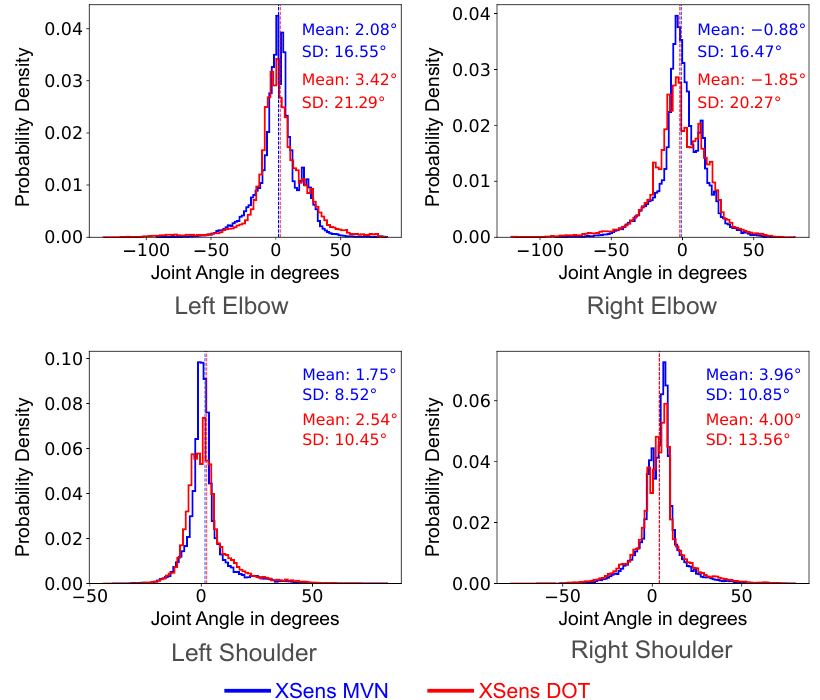
Figure 22. Joint angle error distribution for selected joints. The blue histogram shows the error distribution for the MVN segments, while the red histogram shows the error distribution using the DOT sensors (variable mapping, Configuration 1). The mean error and standard deviation are shown for each